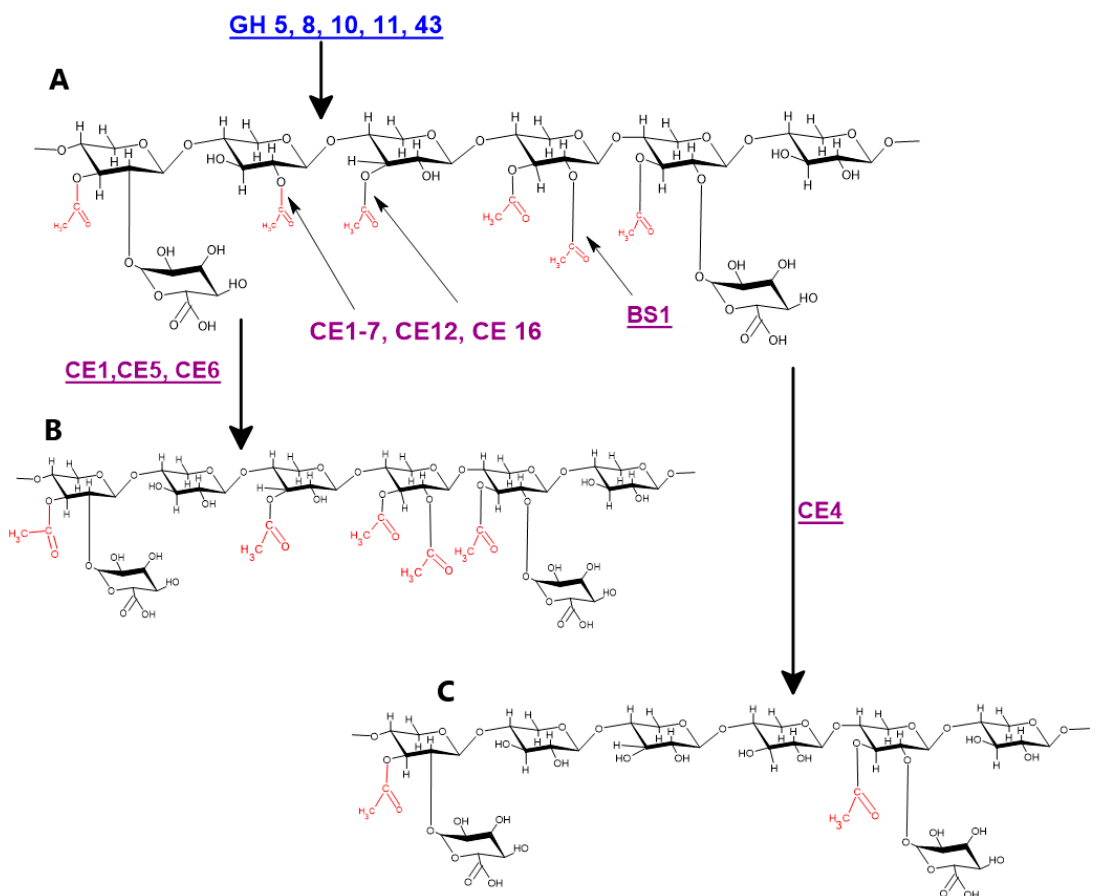
Figure 3. Genes and proteins involved in xylan deacetylation: ( A ) hardwood acetylated xylan; ( B ) CE1, CE5, and CE6 catalyzed deacetylation of hardwood xylan; and ( C ) CE4 catalyzed deacetylation of hardwood xylan. Blue colored genes indicate different endo-xylanases, while purple color indicates different xylan deacetylating enzymes.